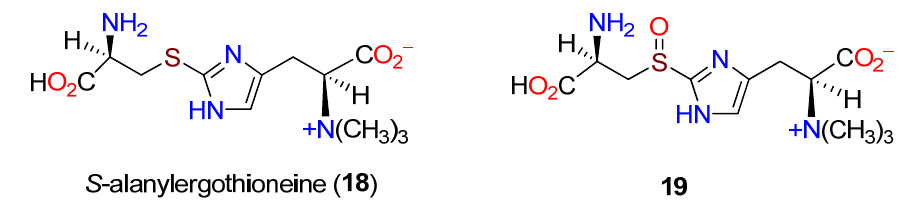
Figure 3. Structures of S -alanylergothioneine ( 18 ) and 19 .